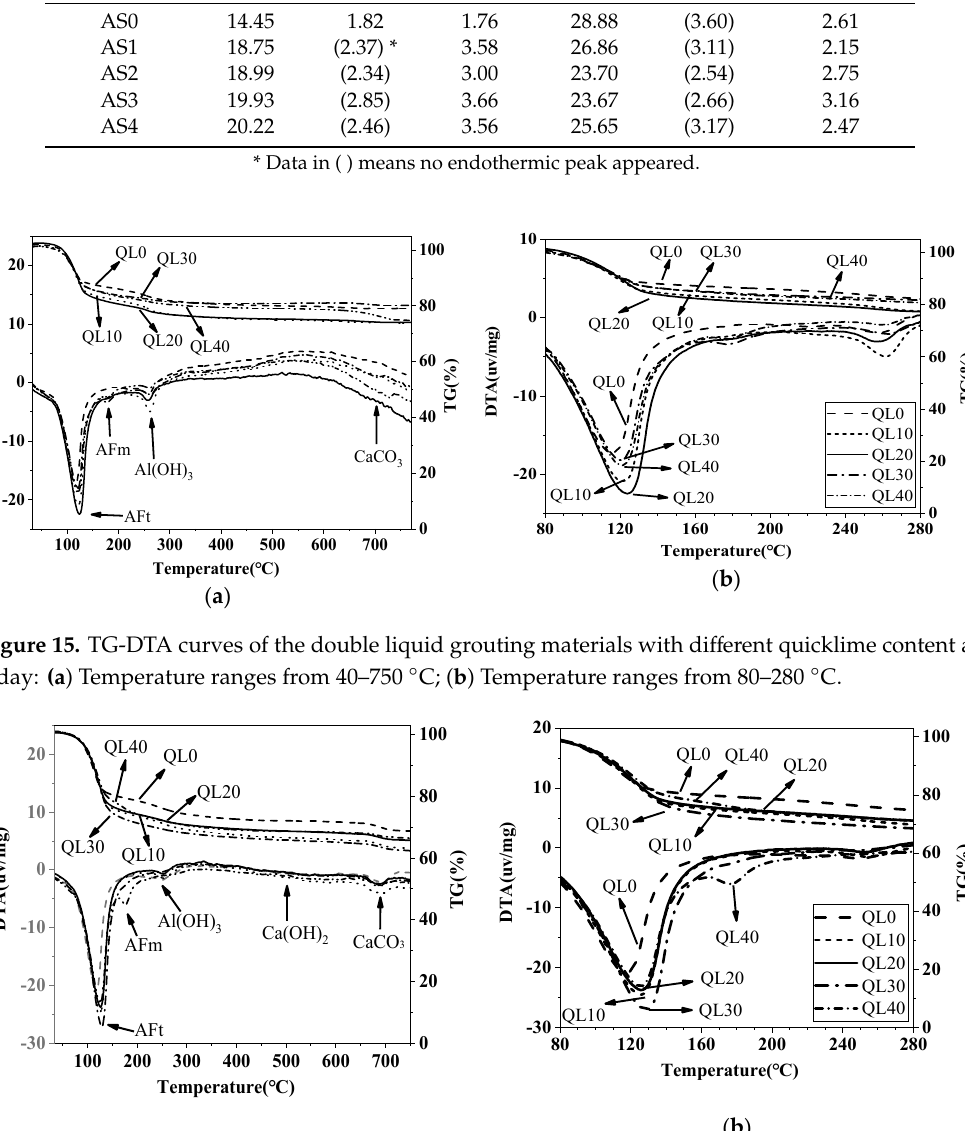
Table 6. Weight loss of the double liquid grouting materials with di ff erent aluminum sulfate content. Mix No.